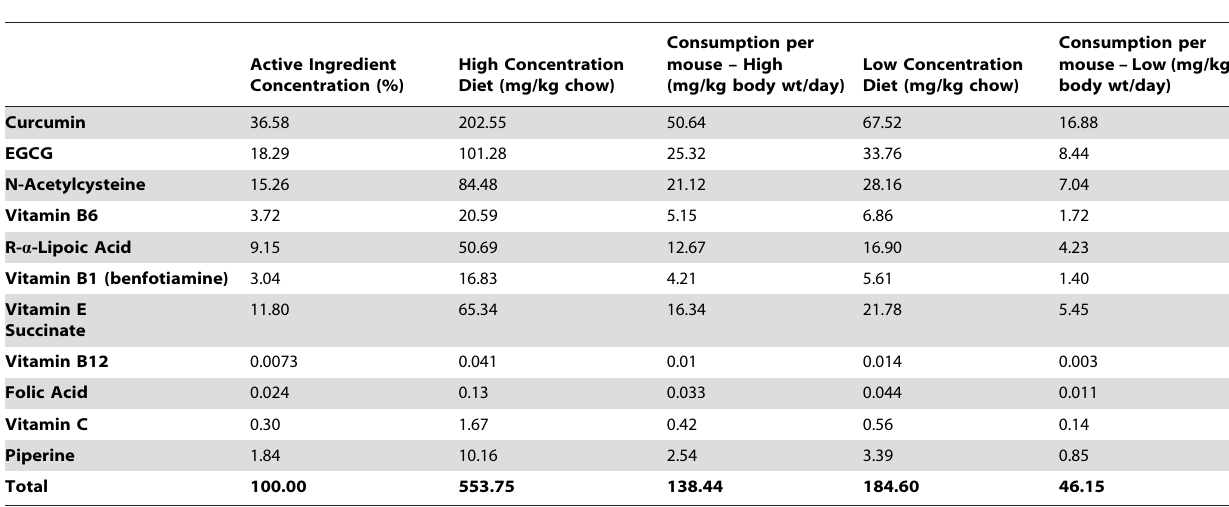
Table 1. Components of high and low nutrient combination diets added to AIN-17 rodent chow.